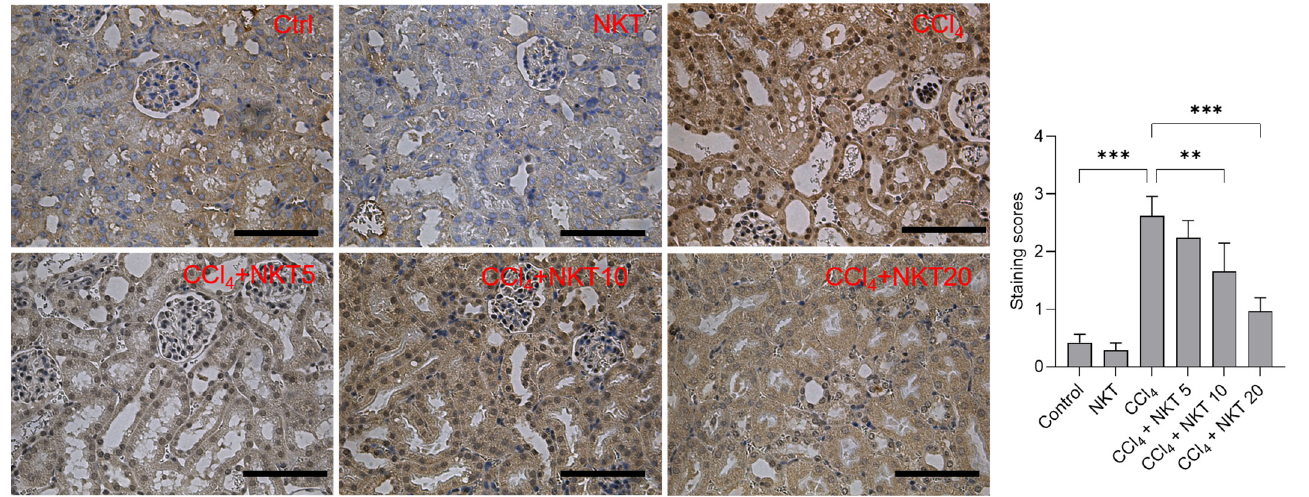
Figure 8. Immunohistochemical images of NOX4 protein in the kidney tissue. After treatment, the expression of NOX4 protein in the kidney tissues was measured by using an immunohistochemical staining method. The representative images ( on the left ) and semi-quantitative analysis ( on the right ) were shown. ** p < 0.01 and *** p < 0.001. Bar = 50 μ m.